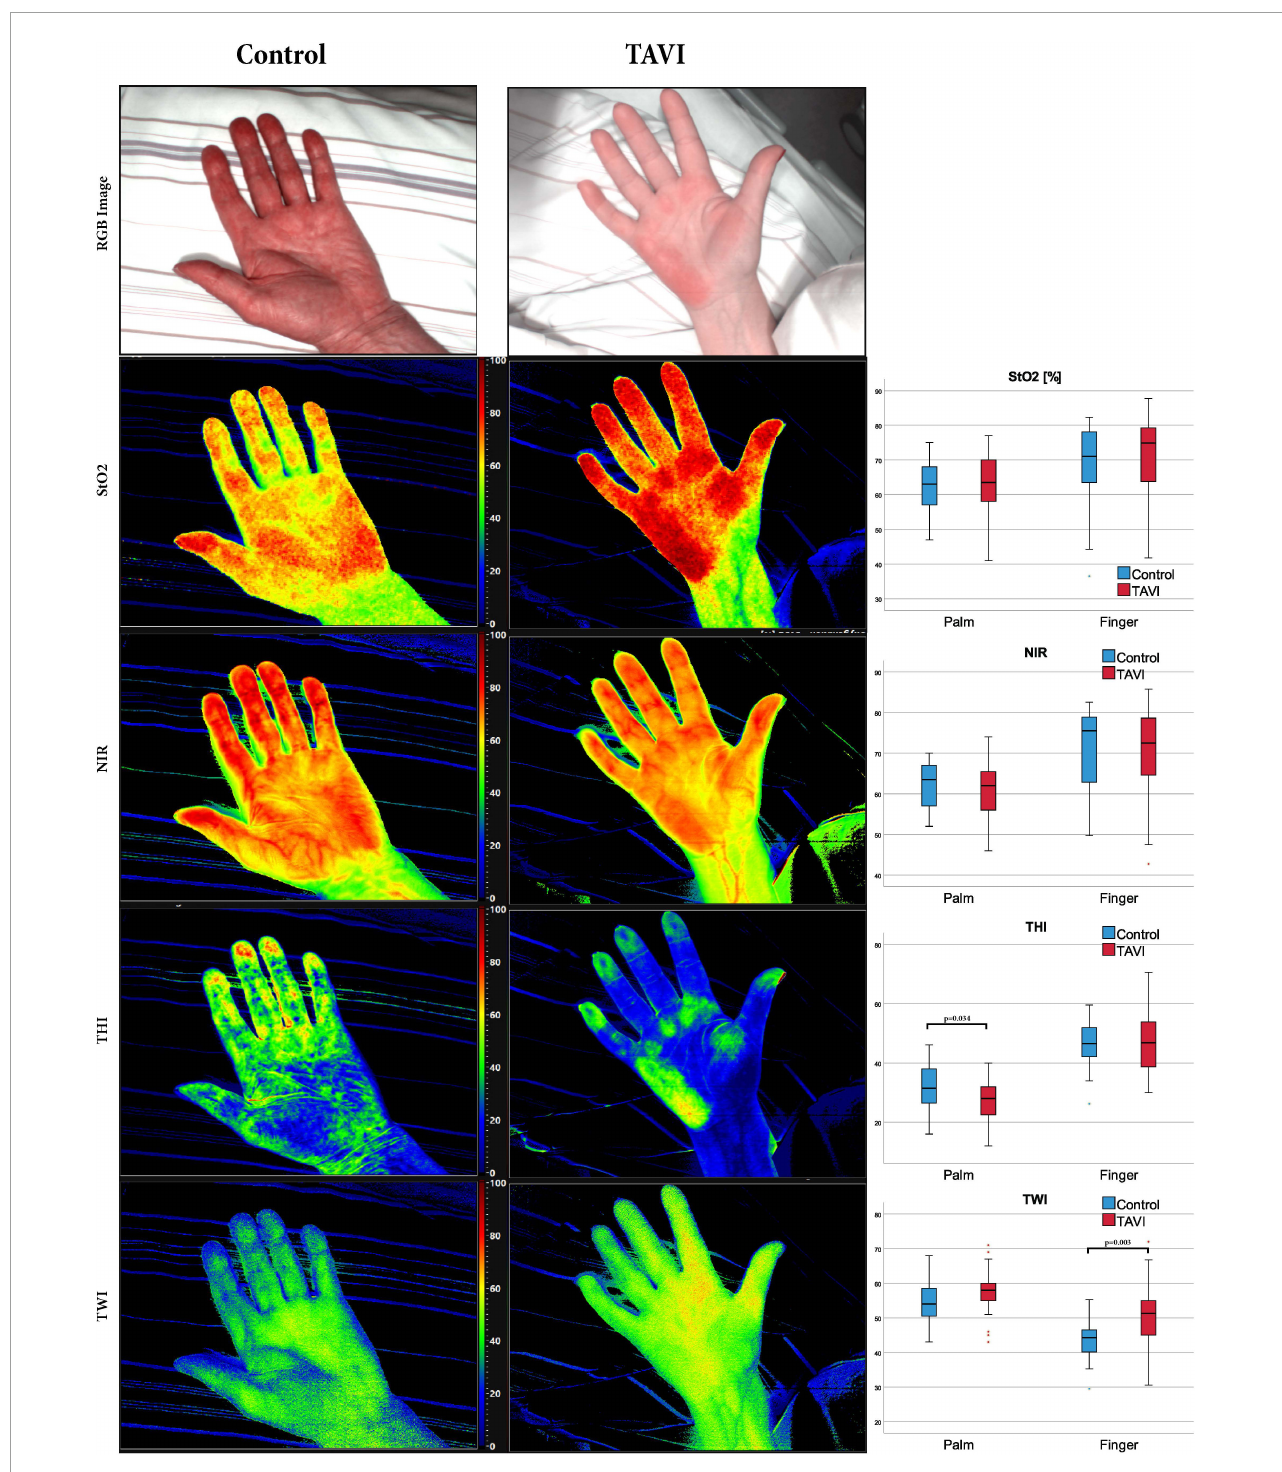
FIGURE1 Red-green-blue image and images derived from HSI of the palm. Boxplots show the respective HSI measurements of TAVI and Control patients; Tissue oxygenation (StO2), near-infrared perfusion index (NIR), tissue hemoglobin index (THI) and tissue water index (TWI) are displayed color-coded (scale at the right side of each image). Red/yellow areas indicate high values (50–100), green/blue (0–50) areas indicate low values. The numerical scale ranges from 0 to 100. StO2 is given in% and THI, NPI, and TWI are index values in arbitrary units. Mann–Whitney-U test was used for comparisons between groups. HSI, hyperspectral imaging; CABG, coronary artery bypass graft; TAVI, transcatheter aortic valve implantation. Additional numerical values are shown in Supplementary Table 1